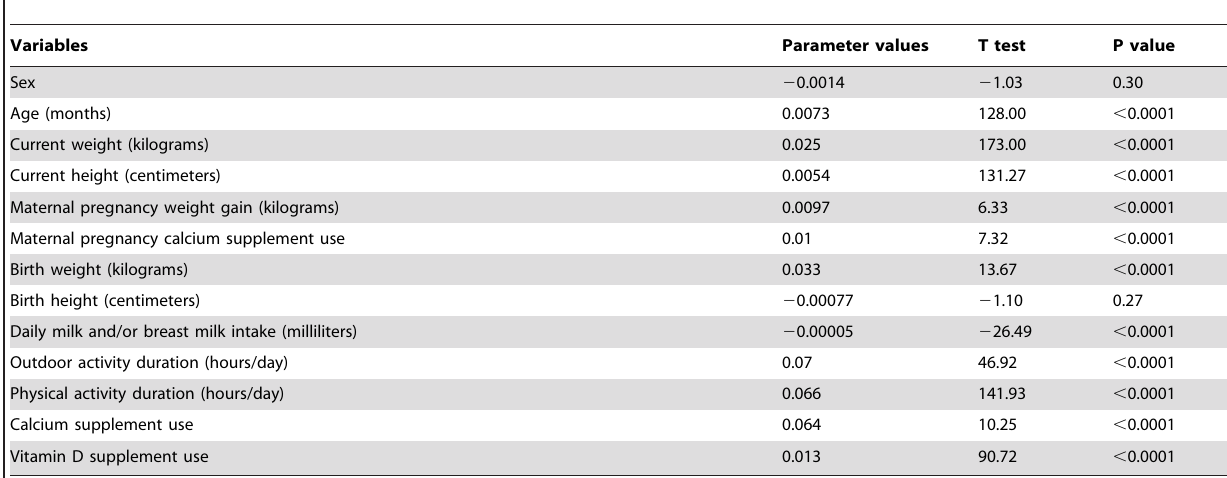
Table 5. Univariate linear regression analysis of individual factors associated with BMD in healthy term Chinese children ages 0–3